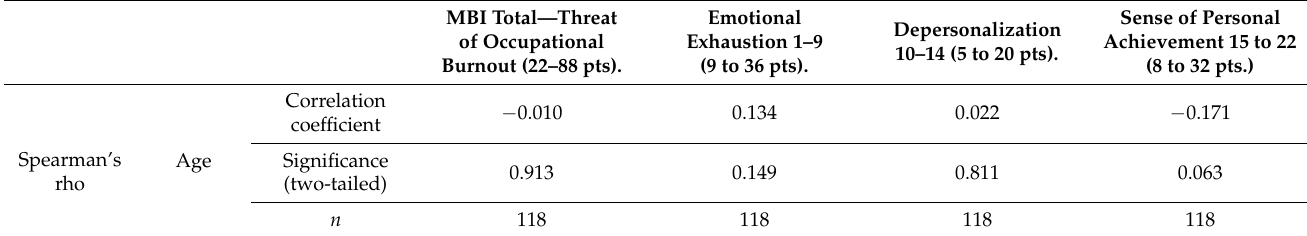
Table 6. Occupational burnout vs. age of